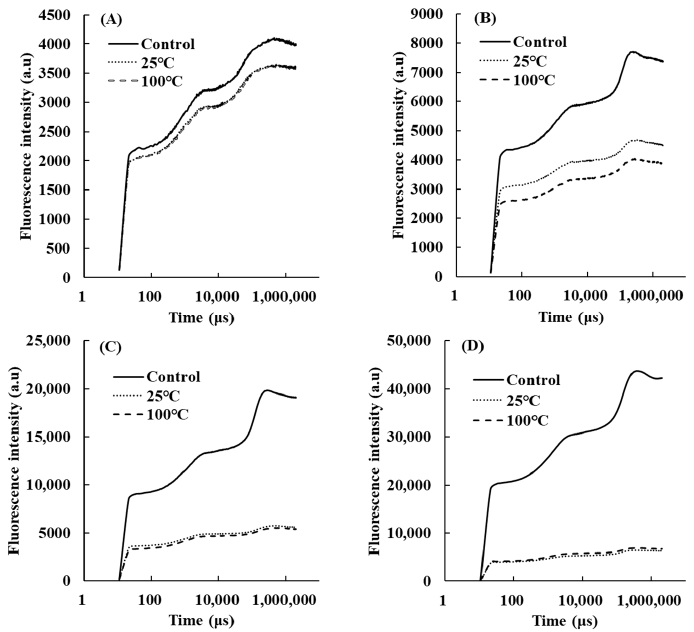
Figure 4. The fast chlorophyll fluorescence induction curves of M. aeruginosa in response to water-soluble substances extracted from D. indicum flowers at 2.0 g·DW·L − 1 with normal temperature water (25 °C) and boiling water (100 °C) during a 9-day bioassay. ( A ) day 0; ( B ) day 3; ( C ) day 6; ( D ) day 9. The parameters extracted from OJIP curves using JIP test analysis, including Fv/Fm, ψ o , φ Eo, and PIABS of M. aeruginosa cells in both treatments, showed no obvious differences ( p > 0.05), but were significantly lower than those in the control ( p < 0.05) after 9 days. The ETo/RC of M. aeruginosa cells in both treatments was also significantly lower than that in the control ( p < 0.05). The values of ABS/RC and DIo/RC of M. aeruginosa in both treatments were higher than those in the control, and the differences between the control and the treatments increased over time. However, there was no significant difference in TRo/RC between the control and the treatments (Table 2).